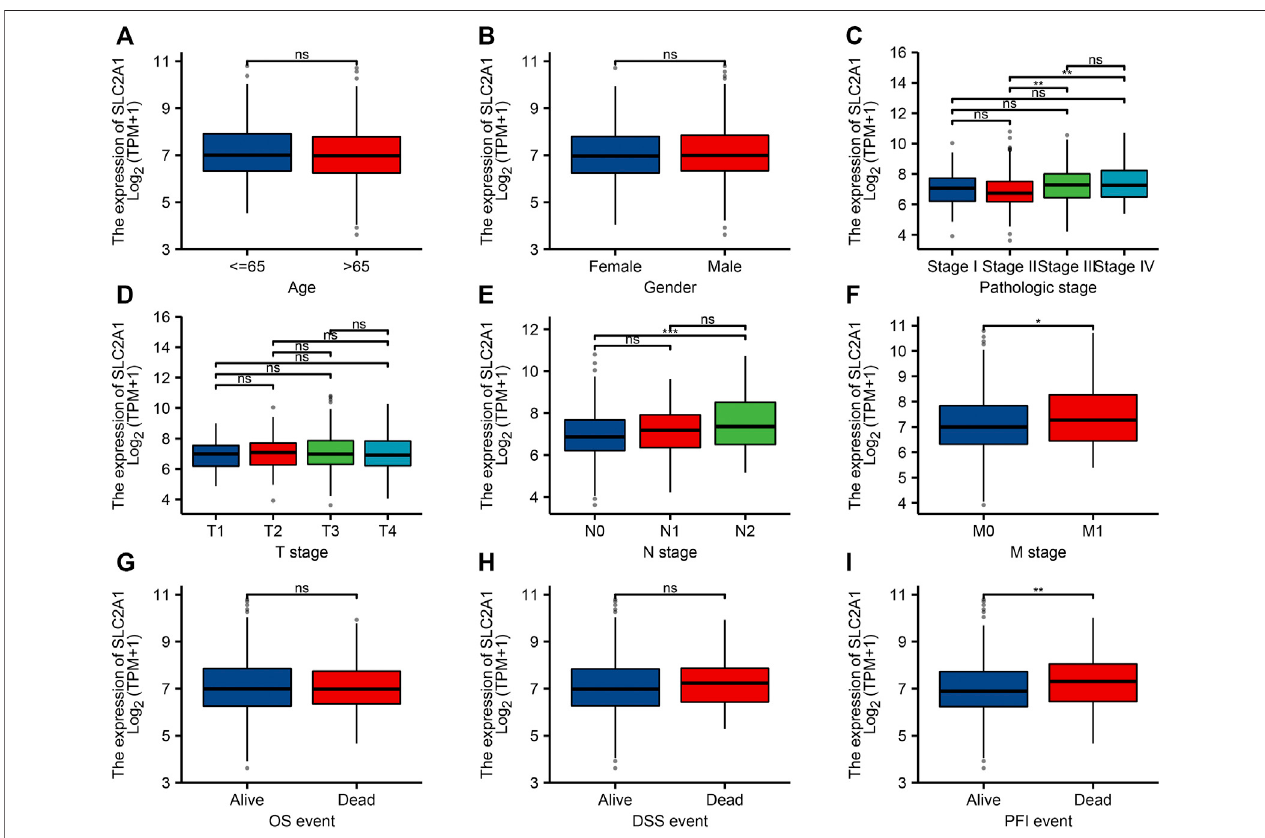
FIGURE 3 | Relationship between SLC2A1 mRNA expression and clinicopathological parameters in patients with colorectal cancer (CRC). The SLC2A1 mRNA expression level was expressed by utilizing ggplot2 software package of R language for the patient characteristics of (A) age, (B) gender, (C) pathologic stage, (D) T stage, (E) N stage, (F) M stage, (G) OS event, (H) DSS event, and (I) PFI event. *, p < 0.05; **, p < 0.01; ***, p < 0.001; ****, p < 0.0001; ns, no signi fi